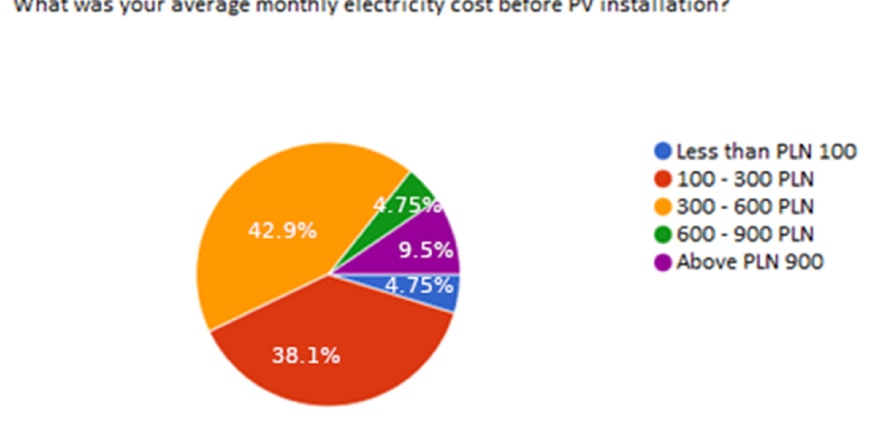
Figure 3. The monthly cost of electricity.